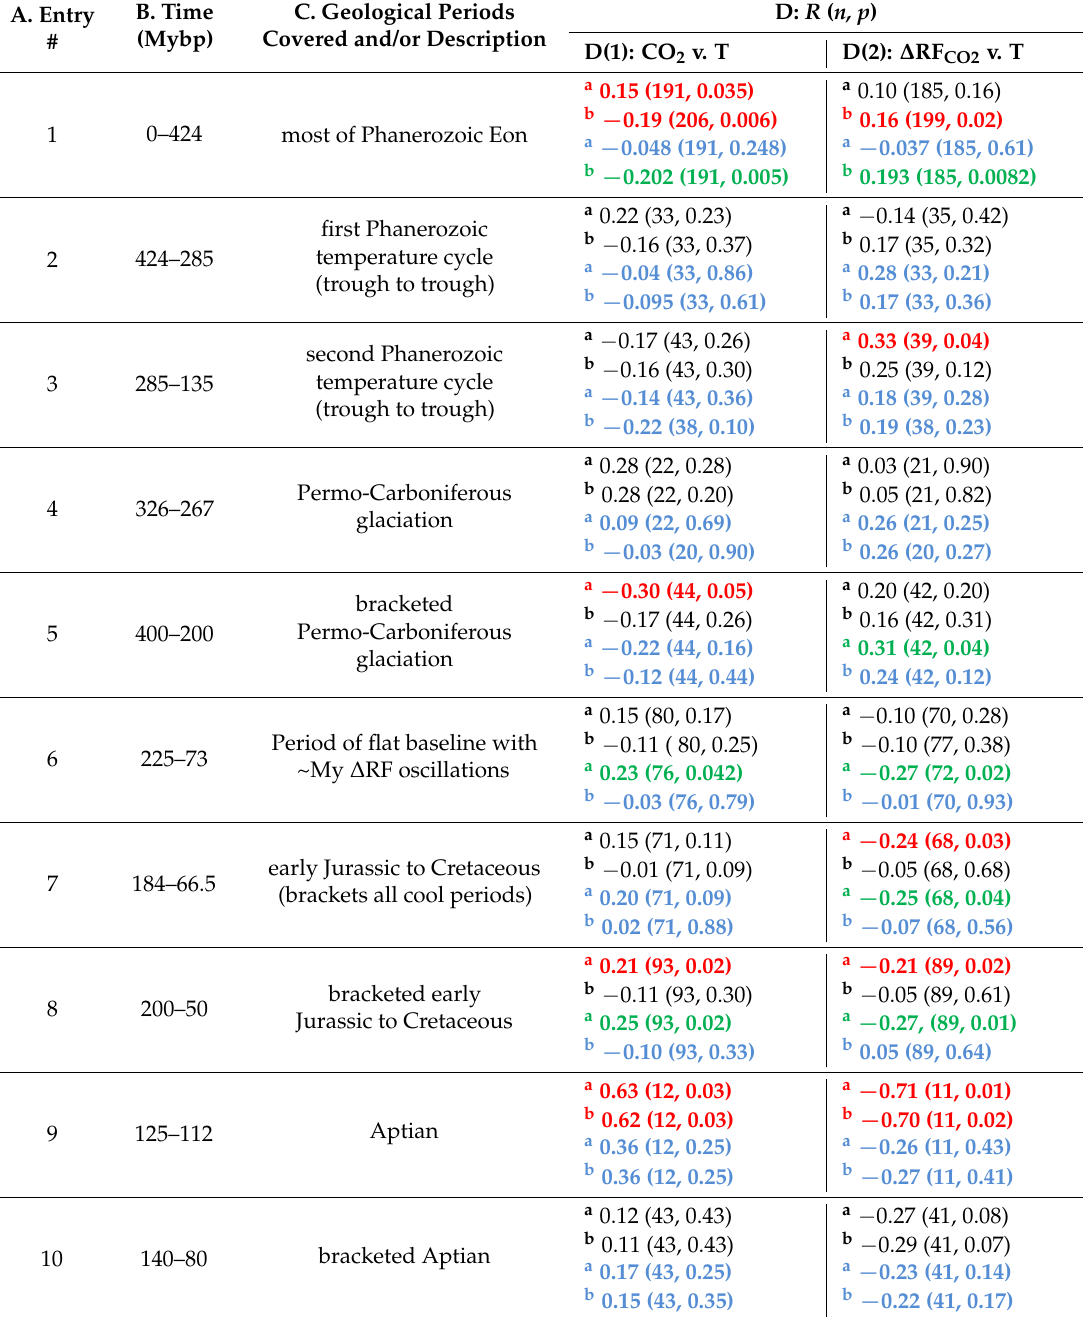
Table 2. As in Table 1, but for the most ancient (lowest resolution) time periods of the Phanerozoic